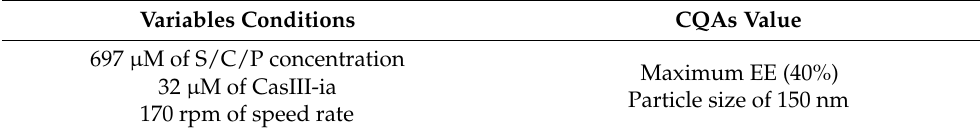
Table 3. The niosome preparation conditions for optimized formulation ( n = 3).